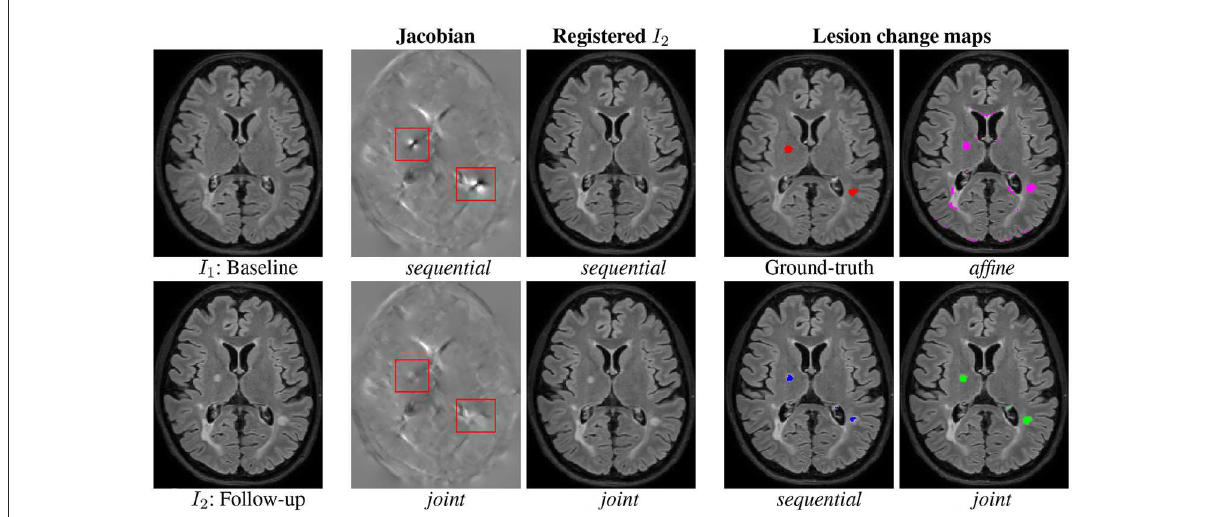
FIGURE4 Qualitative comparison of the binary change detection maps obtained with the three methods and of the jacobian of the deformation field estimated with the sequential and joint approaches on one selected subject from the MSSEG-2 dataset. Hyperparameters: λ 1 = 70 (for sequential and joint methods), λ 2 = 25, λ 3 = 3. I 1 : Baseline, I 2 : Follow-up, sequential , joint , Ground-truth, and affine .